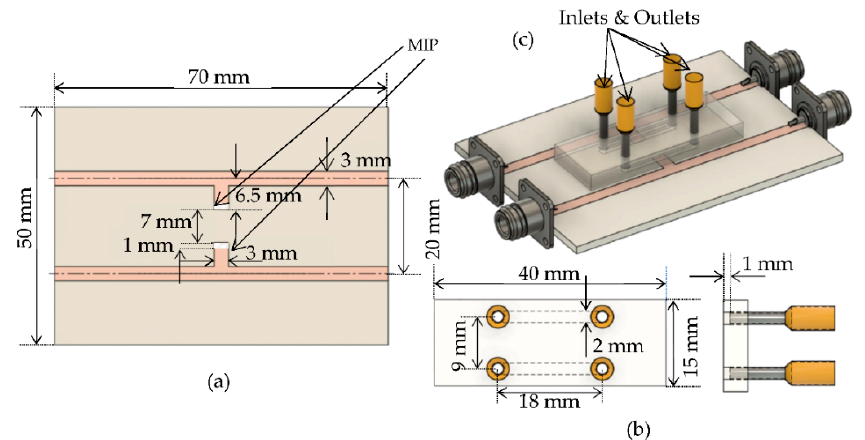
Figure 2. The designed MIP-coated microwave-based stub biosensor ( a ) Top view of the biosensor ( b ) Top view and side view of the microfluidic system with the inlets and outlets ( c ) View of the assembled biosensor.